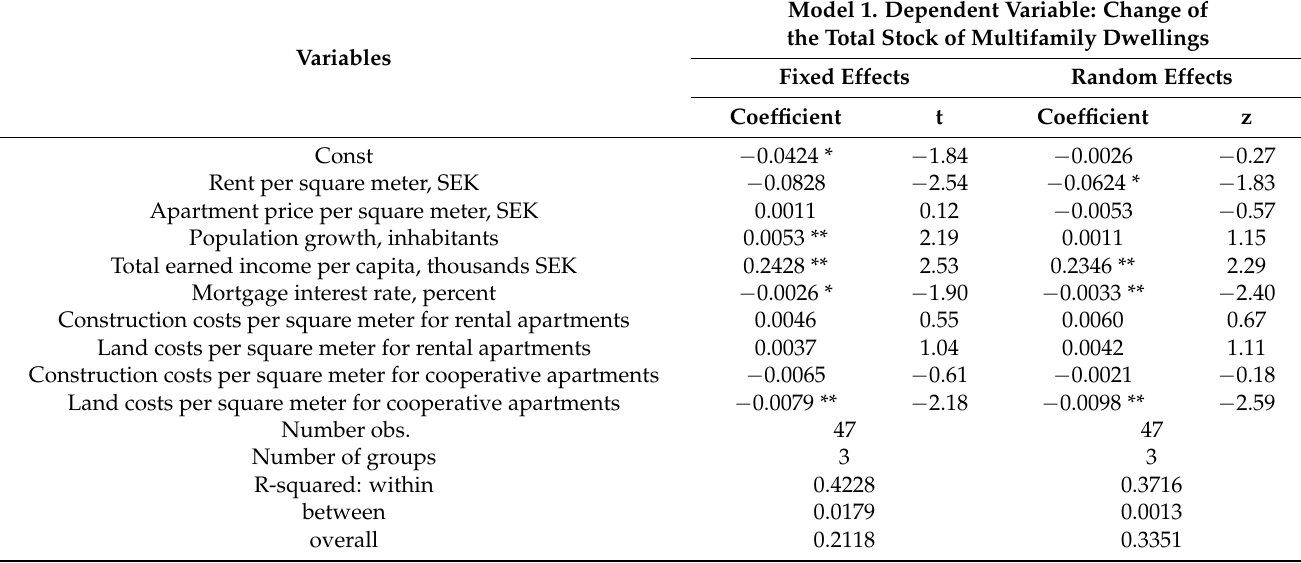
Model 1. Dependent Variable: Change of the Total Stock of Multifamily